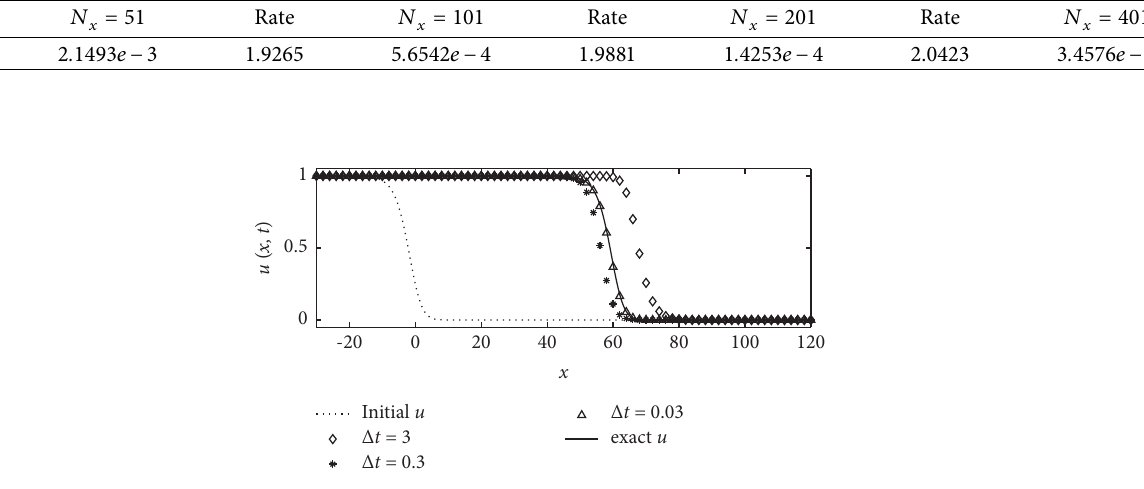
Figure 7: Numerical solutions with respect to three different temporal step sizes Δ t � 0 . 03 , 0 . 3 , and 3 at t �